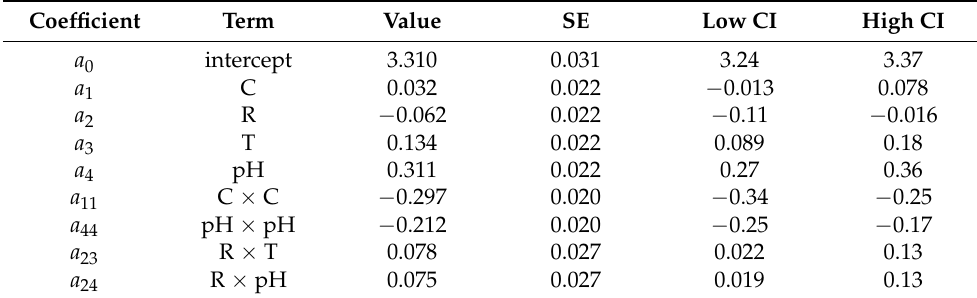
Table 3. Estimated coefficients for the reduced model described by Equation (2) with the associated standard errors (SE) and 95%-confidence intervals (CI). Coefficient